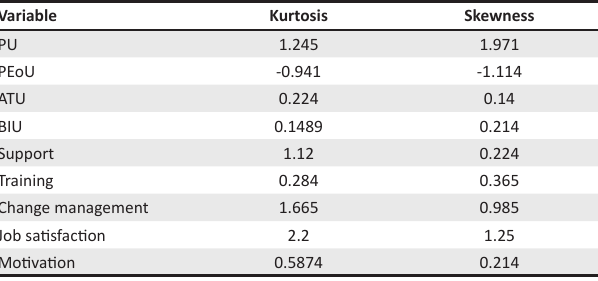
TABLE 3: Skewness and Kurtosis tests for